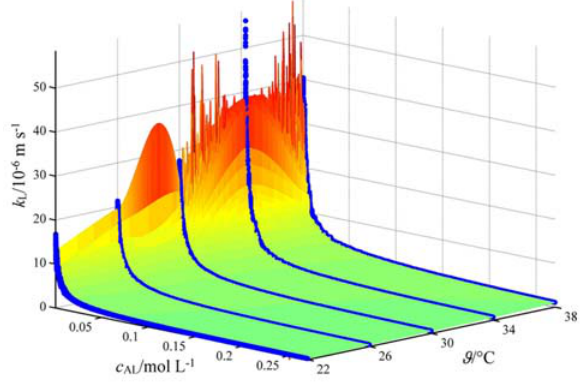
Figure 2. Surface plot of mass transfer coefficients, k tion of temperature and sodium hydroxide concentration in the bulk liquid, at mole fraction of ethanol, x